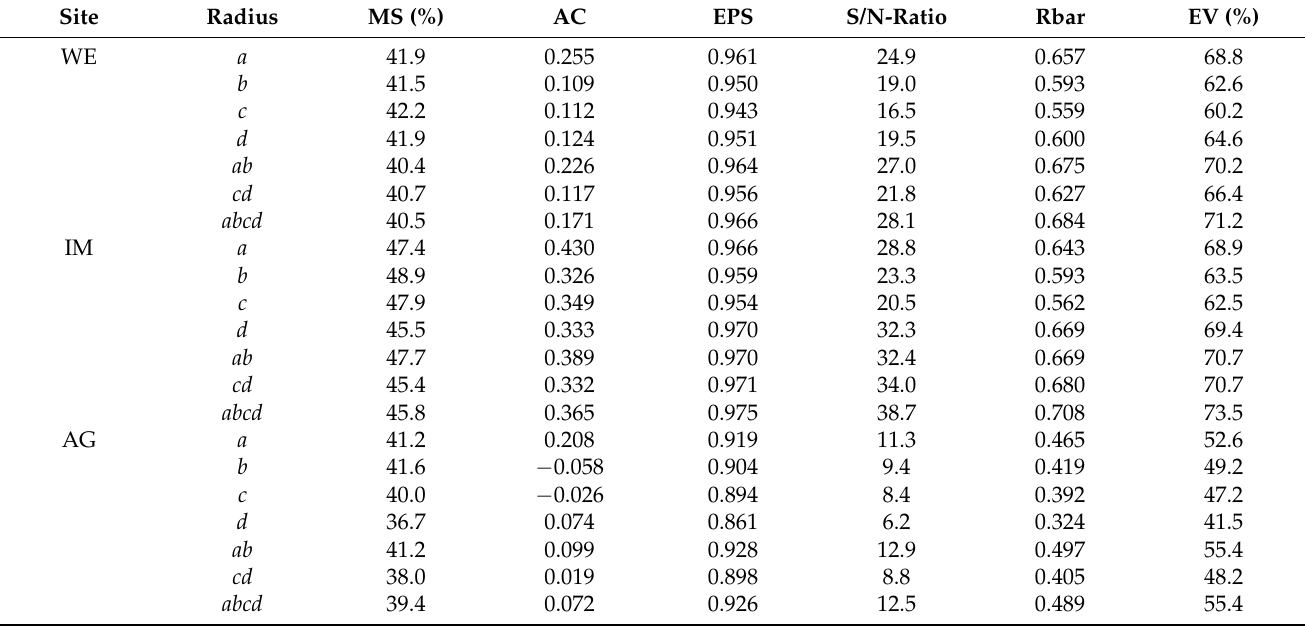
Table 2. Statistics of ring-width series measured along different radii ( a – d ) and mean values of combi- nations of radii ( ab , cd , abcd ) of all shoots taken from one stock at a wind-exposed ridge (site WE), an in- termediate site (IM) and a north-facing avalanche gully (site AG). Statistics are calculated based on de- trended ring-width series for the common interval 2001–2021 (AC = autocorrelation; EPS = expressed population signal; EV = variance 1st eigenvector; MS = mean sensitivity; Rbar = mean inter-series correlation among